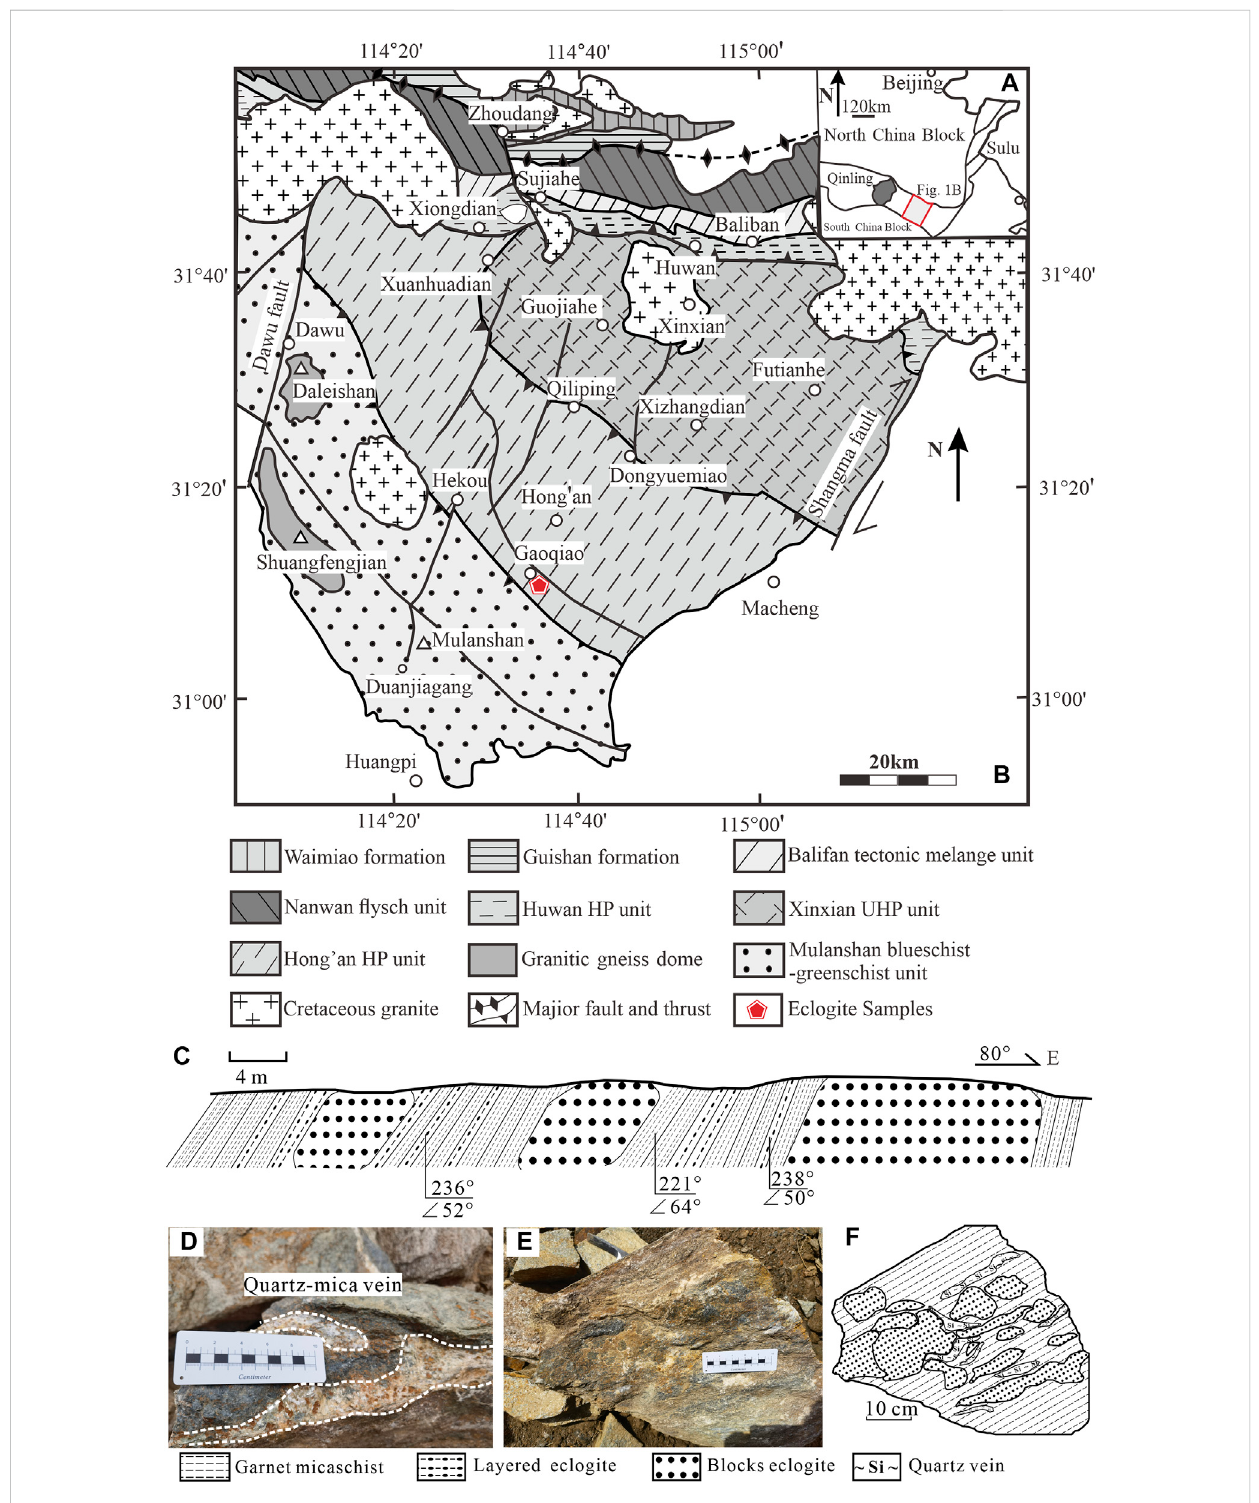
FIGURE 1 (A) TectonicframeworkoftheSulu-Dabie-QinglingorogenincentralChina. (B) Simpli fi edgeologicalmapofwesternDabie(modi fi edafterLiuetal., 2004a). In this study, eclogite was sampled at Gaoqiao in the Hong ’ an HP eclogite unit, western Dabie. (C) Cross-section of eclogite and country rock at Gaoqiao,westernDabie.Eclogiteoccursasblocks(4 – 8 mindiameter)orintercalatedlayers(0.5 – 4 minwidth)inthecountryrockgarnetmicaschist. (D) Quartz-muscovite veinsdevelopedinlayered eclogite. (E) Elongated eclogitefragmentsandquartzveinsroughlyalongschistosity inmicaschist. (F) Sketch of fi eld features for (E)